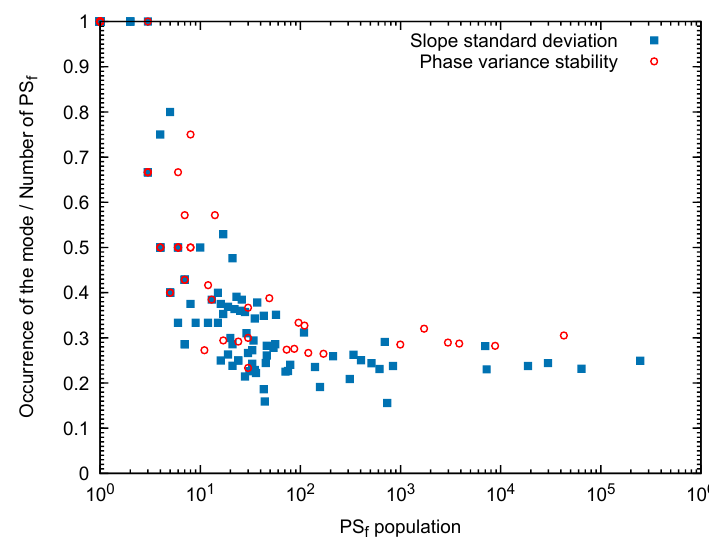
Figure 10. Probability of the mode of the phase-offset distribution as a function of the amount of selected PS f in a given region, for both artificially and naturally disconnected areas. Regions with multiple modes are not represented. The x -axis is on the logarithmic